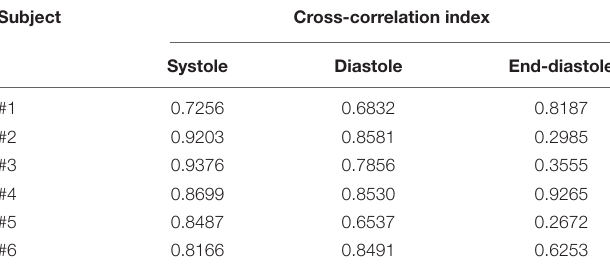
TABLE 4 | Cross-correlation indices of HF-FCG vs. SCG in 3 intervals of the cardiac cycle: [ECG-Q; ECG-Q + 200 ms] (systole); [SCG-AC–50 ms; SCG-AC + 150 ms] (diastole); [ECG-Q–200 ms; ECG-Q]